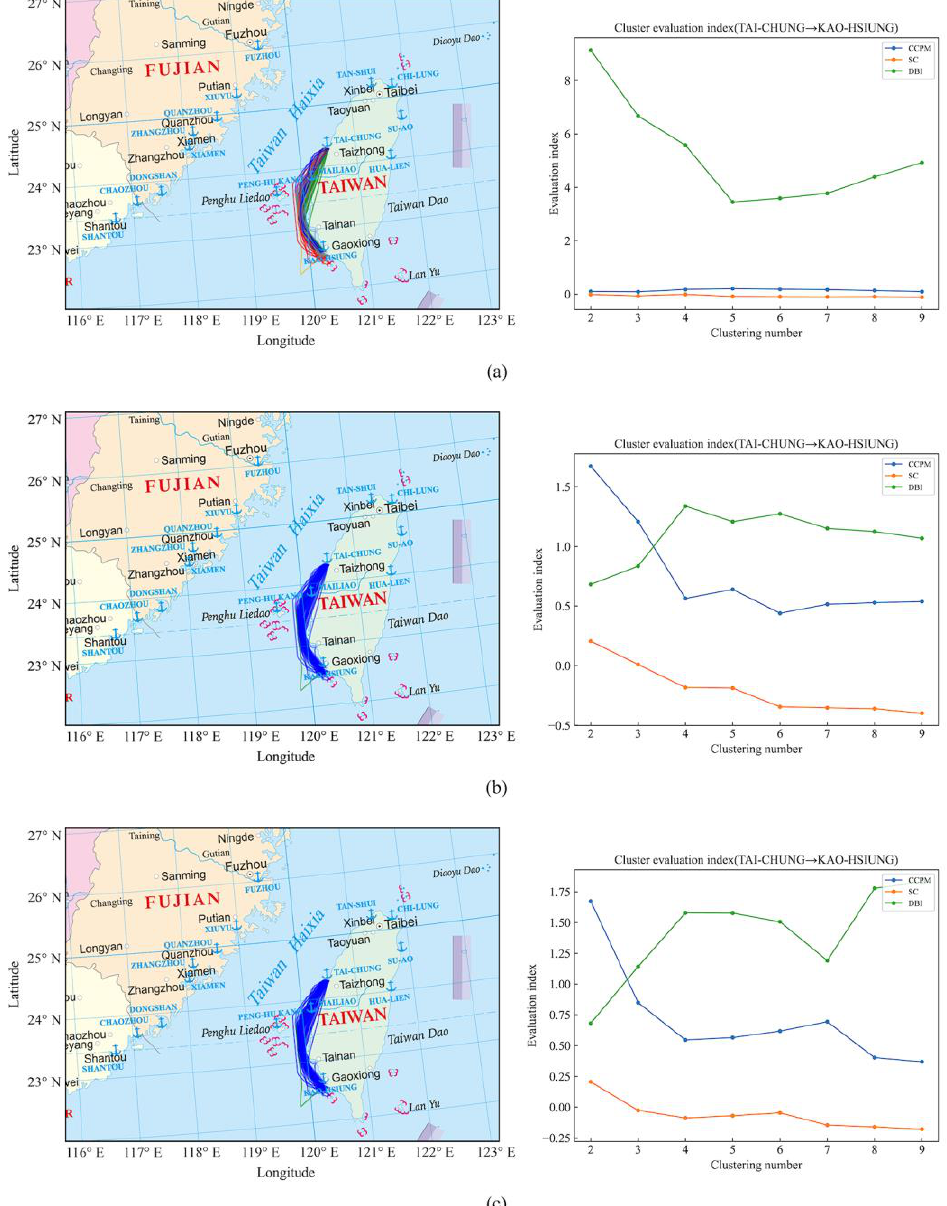
Figure 17. ( a ) K-Means clustering results and quantitative evaluation results of the ship trajectories from Taichung Port to Kaohsiung Port. ( b ) DBSCAN clustering results and quantitative evaluation results of the ship trajectories from Taichung Port to Kaohsiung Port. ( c ) BIRCH clustering results and quantitative evaluation results of the ship trajectories from Taichung Port to Kaohsiung Port.